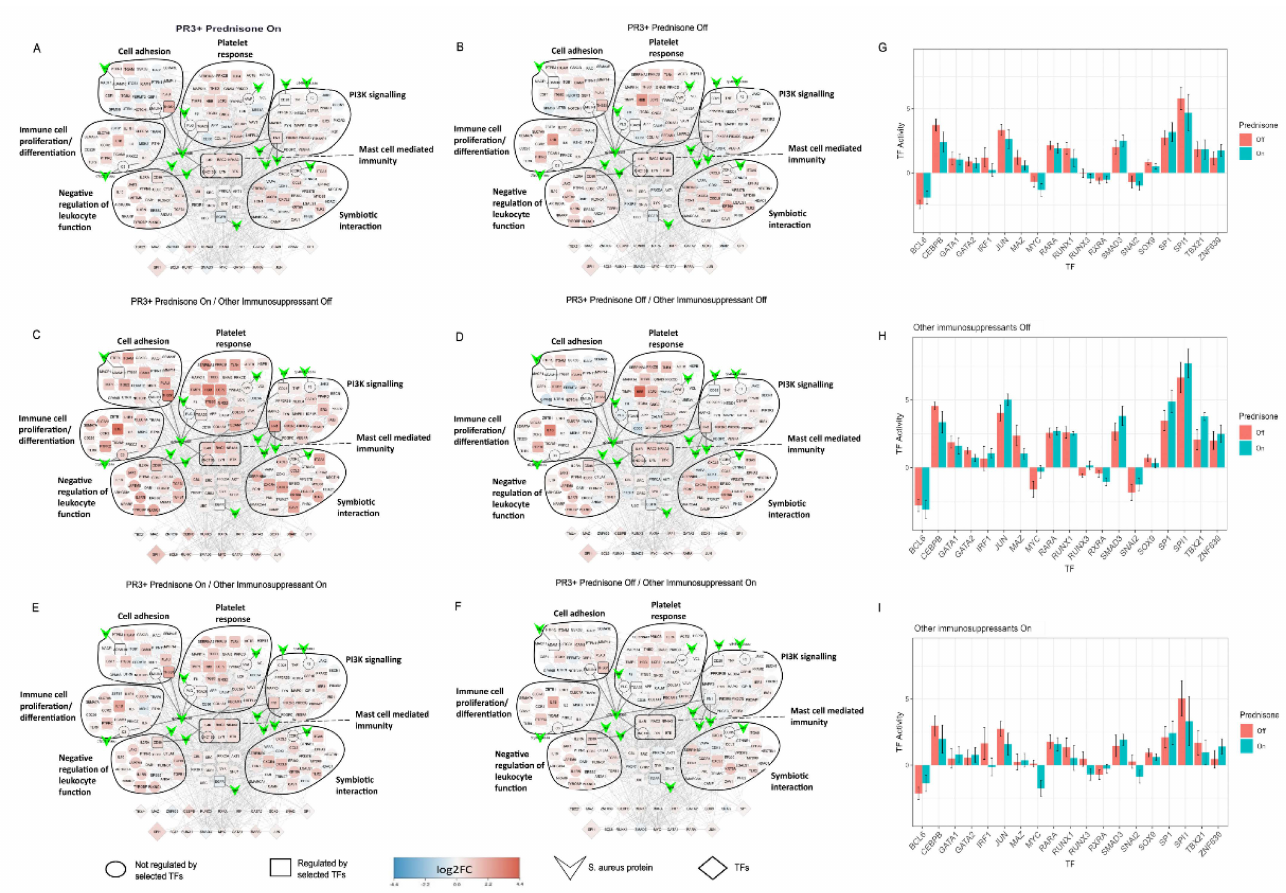
Figure 5. Comparison of SA-PR3+ AAV interaction networks between prednisone on and off treat- ment groups. ( A – F ) Networks and bar charts are as defined in Figure 4. ( A , B ) Patients with pred- nisone showed a slightly increased differential expression when compared to off treatment, suggesting genes in the network remain dysregulated despite being treated with prednisone. ( C , D ) Patients with or without prednisone and without the concomitant use of other immunosuppressants. Patients receiving prednisone alone (no other immunosuppressants) have highly dysregulated genes when compared to treatment-naïve patients. A similar trend as in A and B is seen. ( E , F ) Patients with or without prednisone but with other immunosuppressants. Other immunosuppressant treatment either mono or in combination with prednisone showed decreased differential expression levels, i.e., decreased dysregulation suggesting that other immunosuppressant treatment on its own or in combination with prednisone might revert the dysregulation. ( G – I ) TF activities for prednisone on/off ( G ) with immunosuppressants on/off ( H – I ) reflects the changes observed in the SA-PR3+ AAV interaction networks for the respective patient